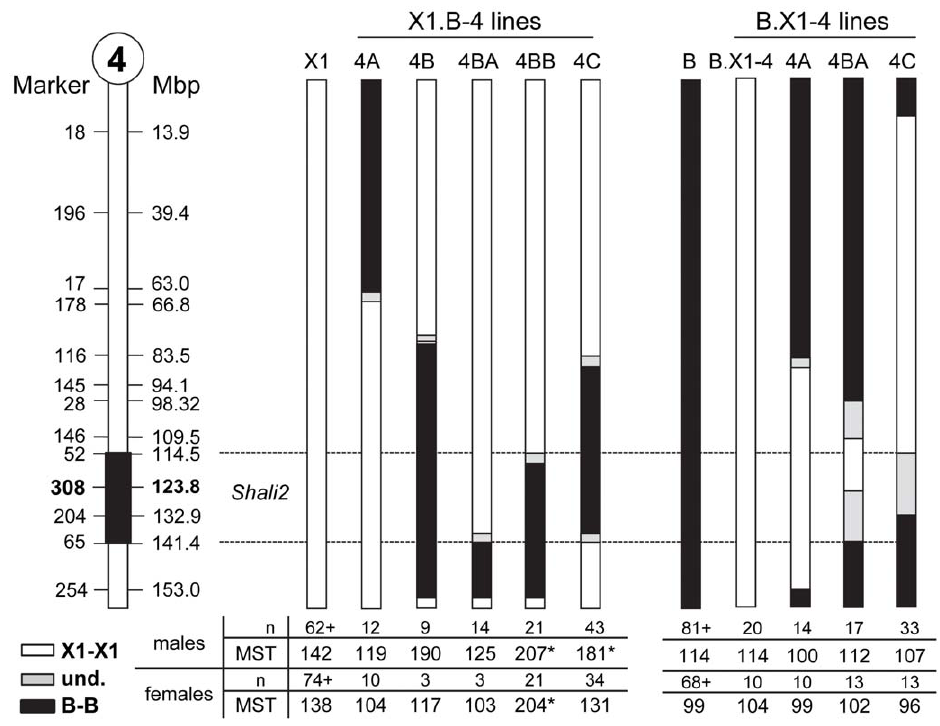
Figure 4. Schematic summary of B.X1-4 consomic and reciprocal X1.B-4 and B.X1-4 congenics and subcongenics for Shali2 . Data represent chromosome 4 of each strain, with X1 (solid white bar) and B (solid black bar) representing the recipient background strain of X1.B-4 and B.X1-4 lines, respectively. Chromosome 4 on the far left depicts MIT markers and their genomic positions (Mbp), along with the Shali2 interval (black box). The current Shali2 interval is also indicated by dashed lines. Crossovers not matching dashed lines indicate SNPs from the Mouse Universal Genotyping Analysis (MUGA; GeneSeek) panel. For X1.B-4 lines (left half), regions in black denote substituted genome, with congenic lines X1.B-4A, X1.B-4B and X1.B-4C. X1.B-4BA and X1.B-4BB are subcongenic lines derived from the X1.B-4B line. For B.X1-4 lines (right half), regions in white represent substituted genome. B.X1-4 represents a consomic line (full chromosome substitution). B.X1-4A and B.X1-4C are congenic lines and B.X1- 4BA is a subcongenic line of B.X1-4B (died). Grey regions represent areas not yet tested for parental origin. Tables below each set of congenic lines summarize mean survival time (MST) and sample size (n) for males and females of each line. *significantly different than same-sex background strain ( p , 0.00132; MWW U-test with Bonferroni correction for 38 group comparisons). + , represents a historical control and includes combined data for new and previously reported controls [24,25].